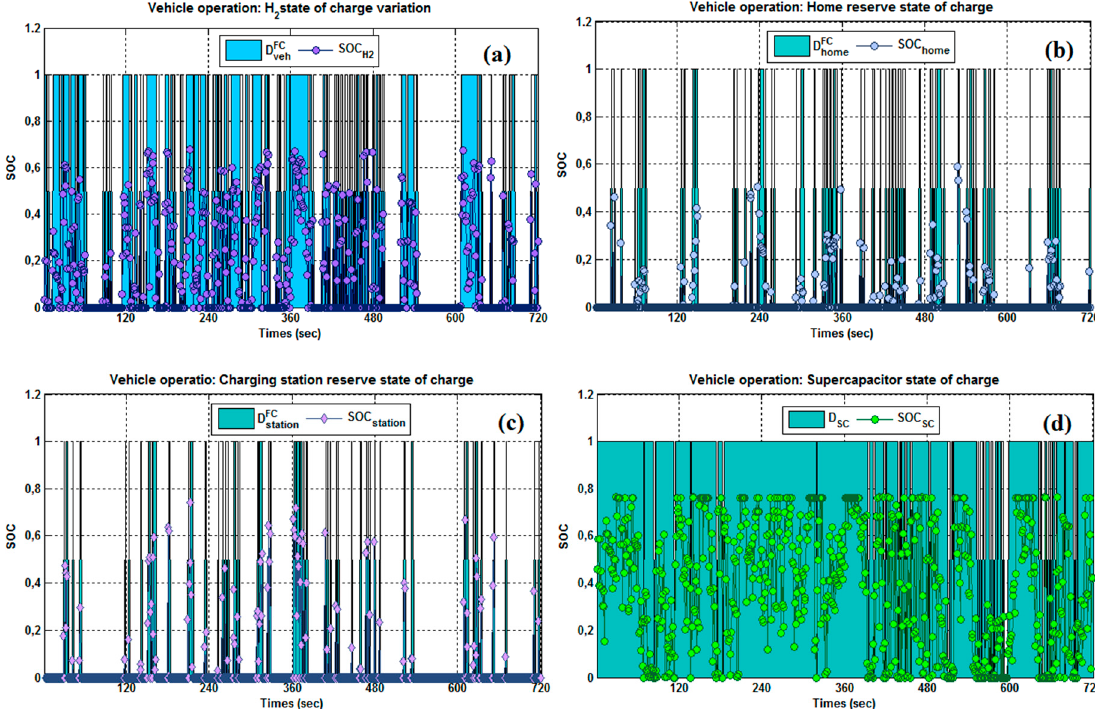
Figure 10. SOC variation and decision key per component: ( a ) FC; ( b ) home; ( c ) charging station; and ( d ) supercapacitor.